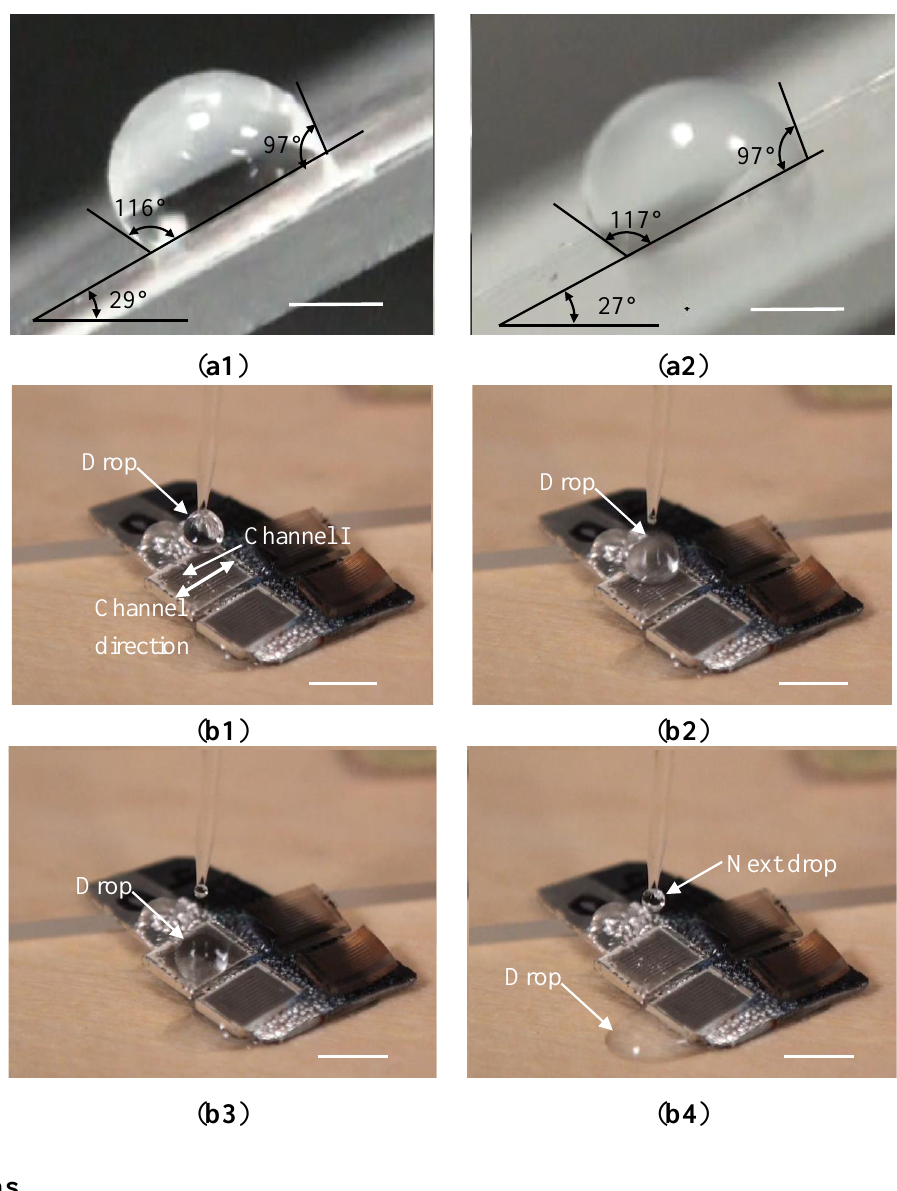
Figure 6. Water drops stuck to as-received PS sheets. ( a1 ) Before; and ( a2 ) After recovery when the sheets were tilted by 29° and 28°, respectively. The scale bars in ( a1 ) and ( a2 ) stand for 1 mm. A water drop rolled off from a substrate that is structured with Channels I when this substrate was tilted at an angle of 5°. ( b1 ) Produce a water drop using a syringe, ( b2 ) Release it to the substrate; ( b3 ) The drop moves down; and ( b4 ) Gets off from this substrate. The corresponding video clip for ( b1 – b4 ) is available in the Supporting Information, and the scale bars represent 4.5